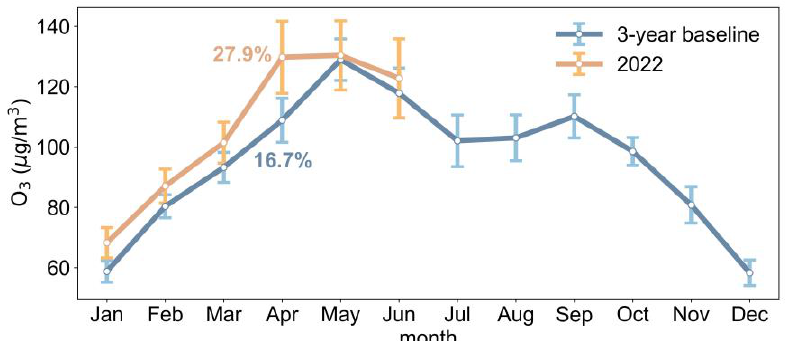
Figure 7. Monthly distribution of 3-year average and 2022 ground-level MDA8 O 3 concentrations in Shanghai, with 95% confidence intervals (error bars). The words show the rate of increase in O 3 concentration in April compared with that in March. Note: the 3 years are 2018, 2019, and 2021. O 3 in 2020 was not considered, because of the impact of the wintertime COVID-19 lockdown.